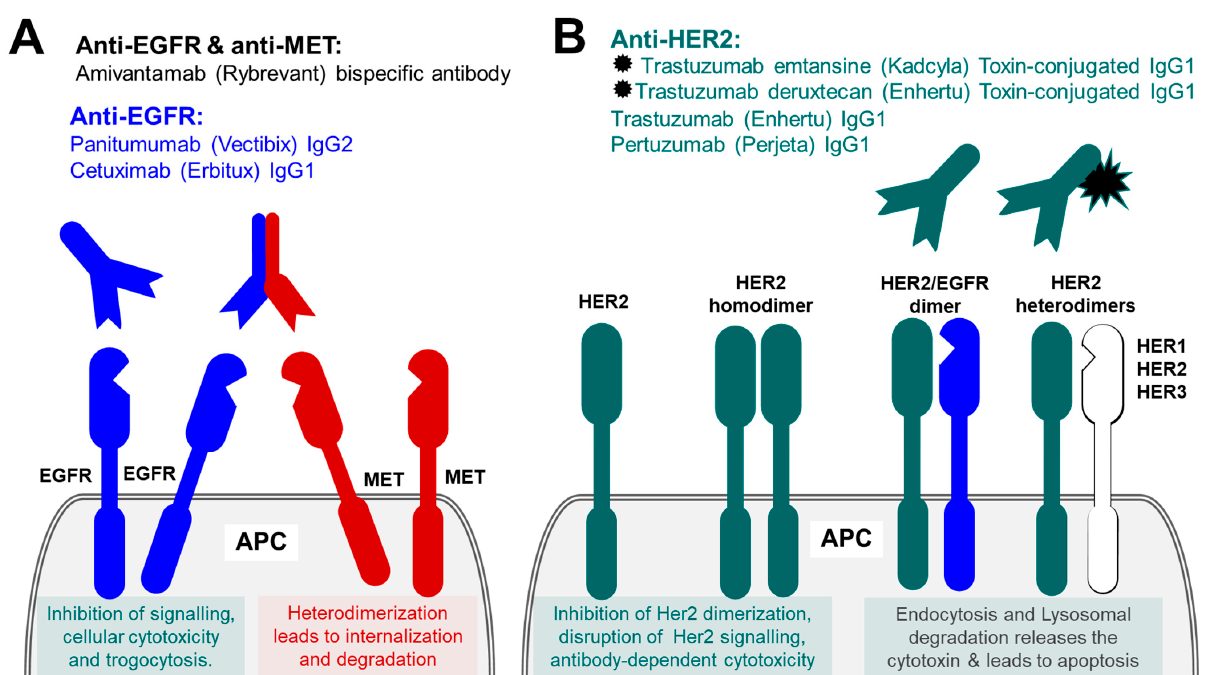
Figure 5. Ubiquitously expressed cancer targets for anticancer antibody therapies. ( A ) Targeting EGFR with monoclonal unconjugated antibodies and bispecific anti-EGFR and anti-MET antibodies. ( B ) Targeting HER2 with monoclonal unconjugated antibodies and cytotoxic drug-conjugated antibodies.